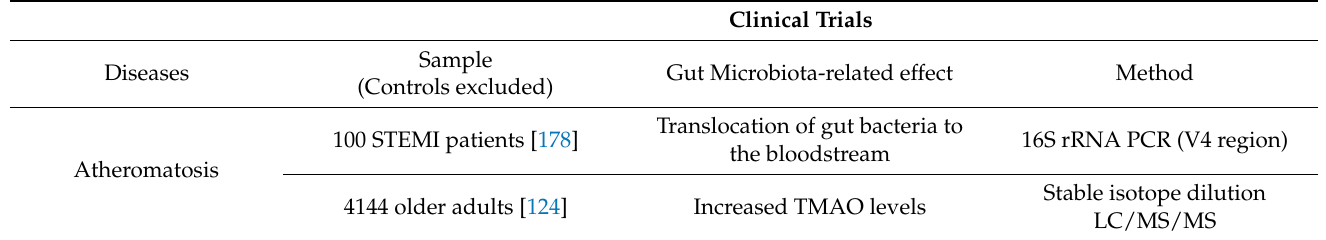
Table 1. Representative clinical trials featuring the interconnection between the gut microbiome and